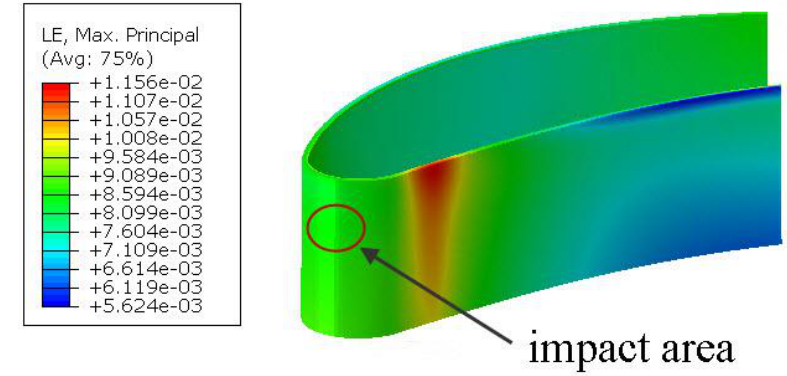
Figure 9. Strains caused by blade heating.